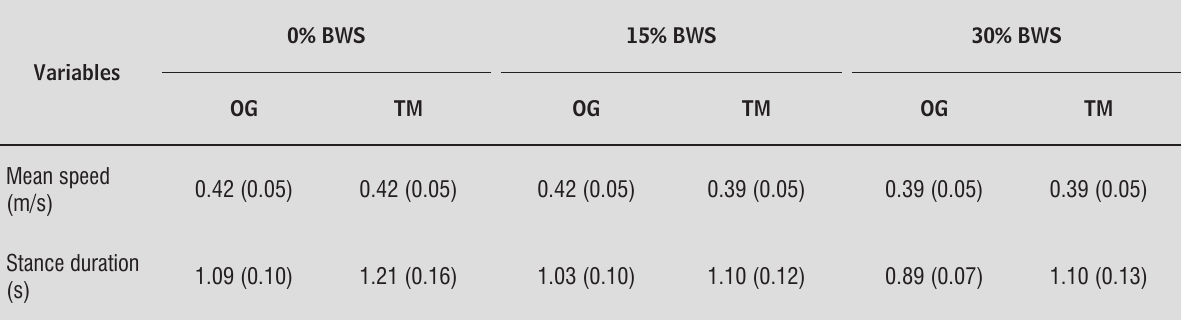
Table 2 - Mean (means standard error) of mean walking speed, duration of stance period, single stance, total double stance and swing, step length, cadence, stride length and speed in the different experimental conditions 0 % , 15 % and 30 % body weight support (BWS), over the ground (OG) and on the treadmill (TM)